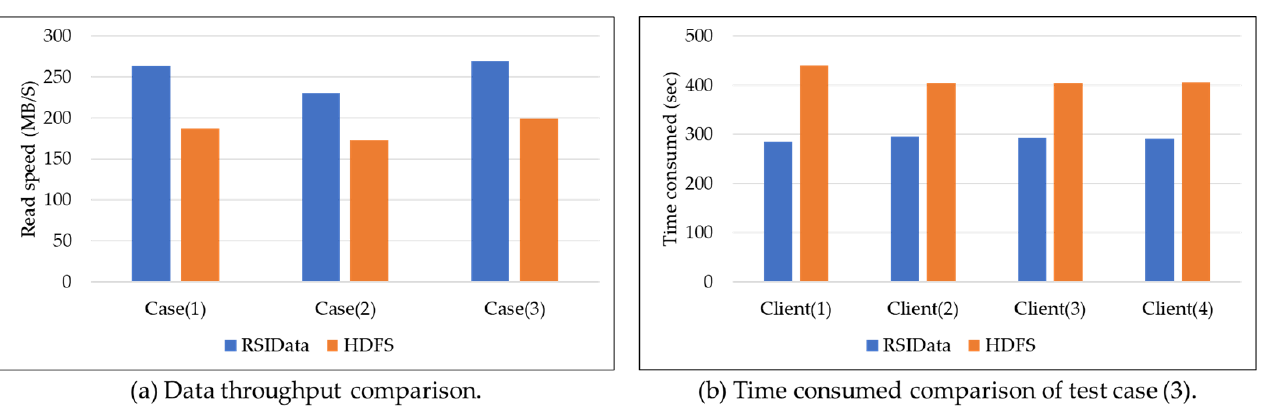
Figure 27. Performance comparison of RSIData and